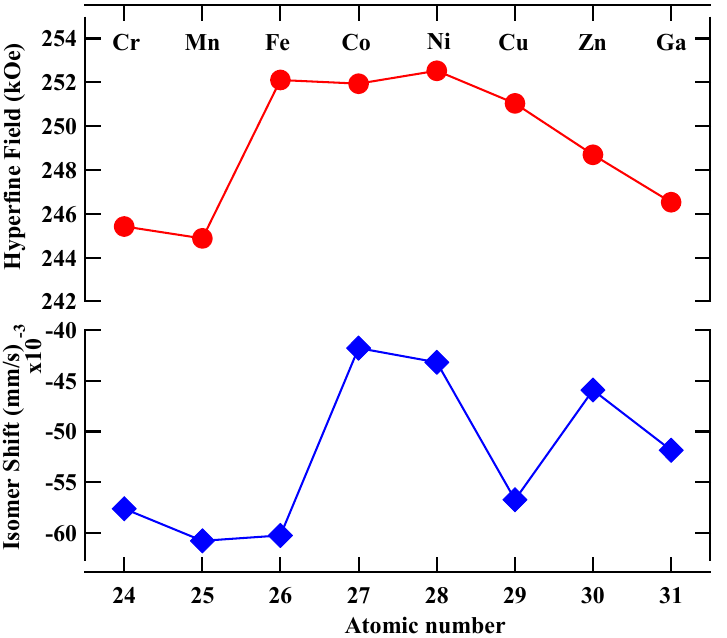
Figure 7. Weighted average hyperfine parameters, hyperfine field, and isomer shift, as a function of TM atomic number for Gd 2 Fe 17 and Gd 2 Fe 16 Ga 0.5 TM 0.5 (TM = Cr, Mn, Co, Ni, Cu, Zn, and Ga).